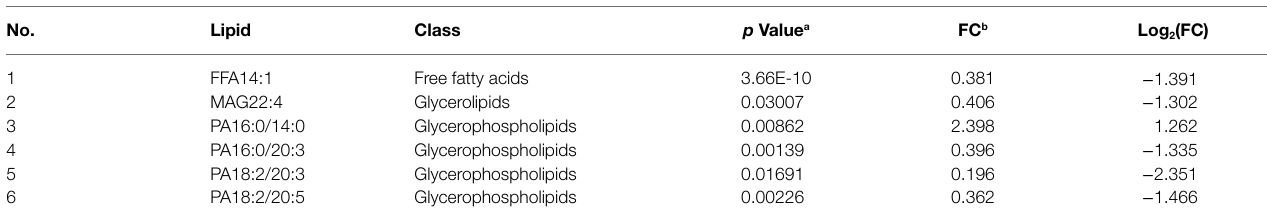
TABLE 9 | Lipids with different levels between male and female NPC